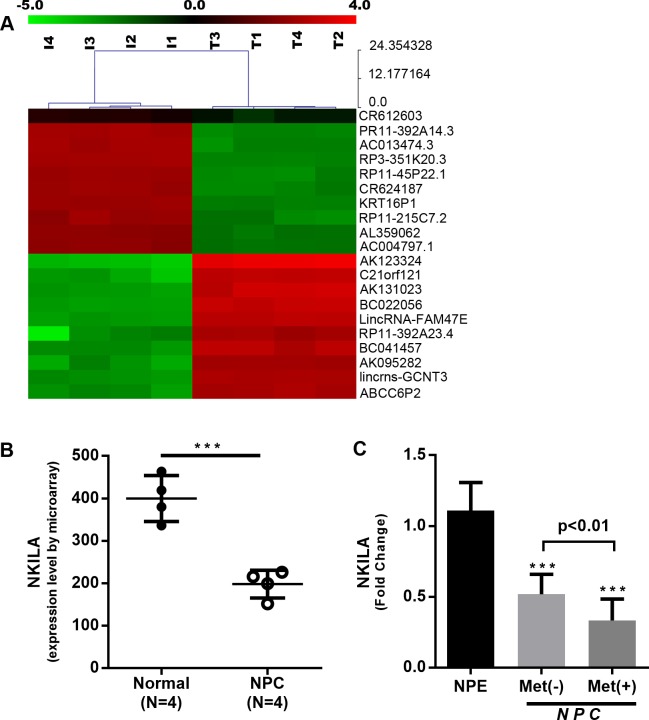
NKILA is downregulated in nasopharyngeal carcinoma.(A) Hierarchical clustering demonstrating distinguishable lncRNA expression profiles among samples from microarray data (P < 0.05). (B) NKILA expression in nasopharyngeal carcinoma as observed by microarray (mean ± SD, ***, P < 0.001 versus Normal). (C) Quantification of NKILA expression by qRT-PCR using NPC fresh frozen tissues. 10 cases of NPE,18 cases of NPC Met (-), 8 cases of NPC Met (+). (***, P < 0.001 versus NPE).